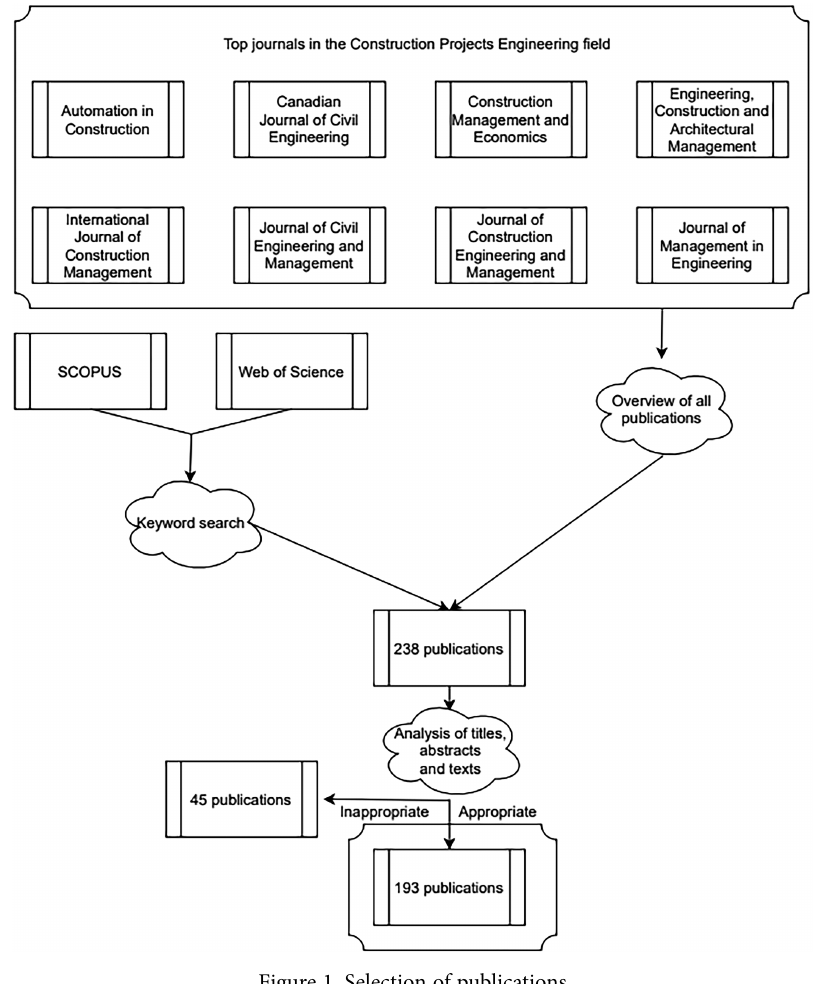
Figure 1. Selection of